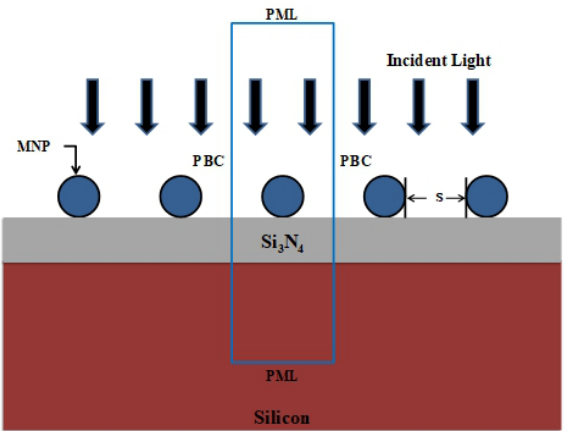
Figure 1. Structural design of thin film Si solar cell with an array of MNP located at the front surface of the